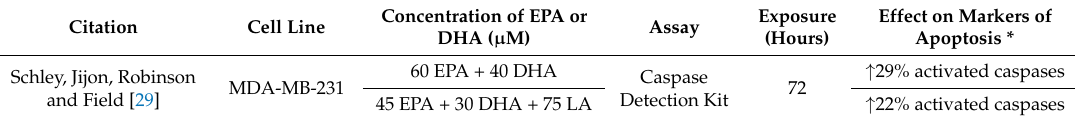
Table 9. Change in apoptotic markers with EPA:DHA mixtures in human BC